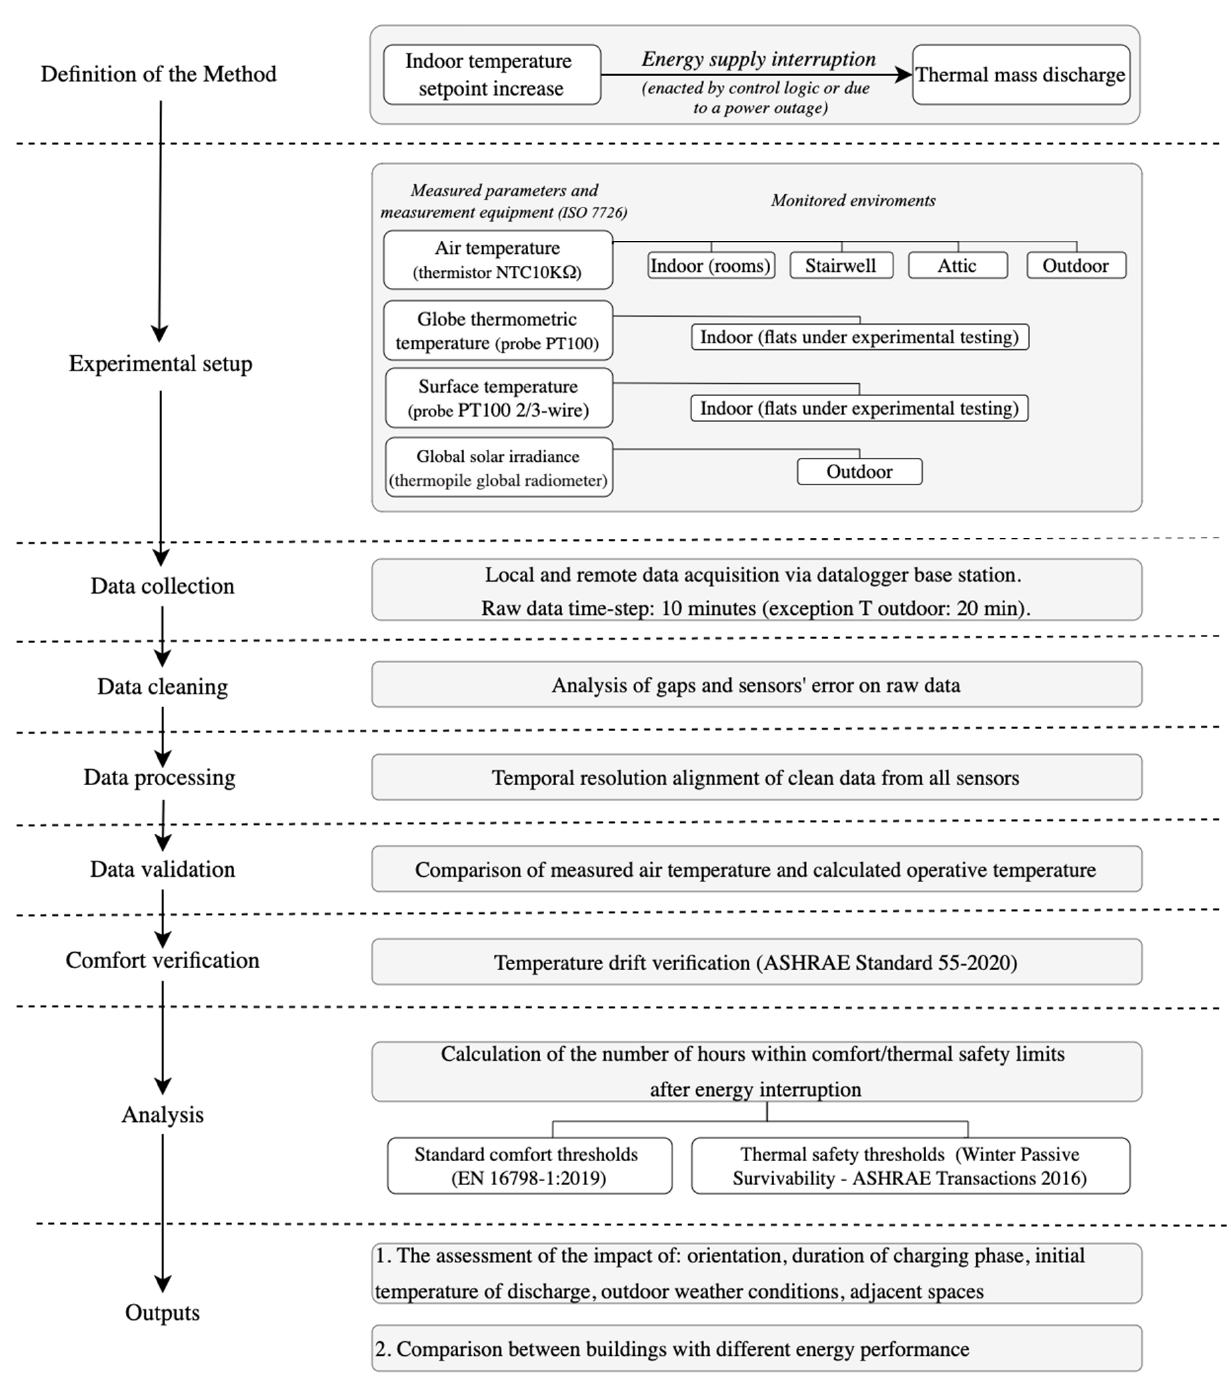
Figure 1. Methodology to assess the potential to deliver “long-term” flexibility in a deeply retrofitted multiapartment building with high thermal mass.